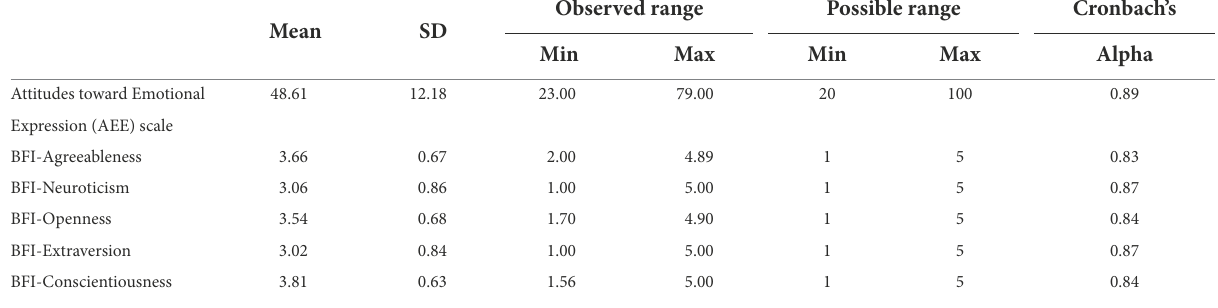
TABLE 4 Descriptive values for the questionnaire tools employed.